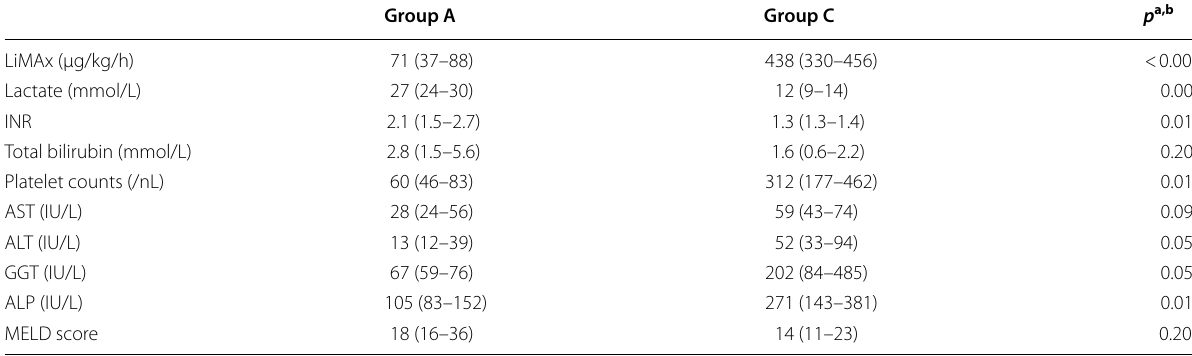
Table 4 Comparison of static and dynamic liver parameters